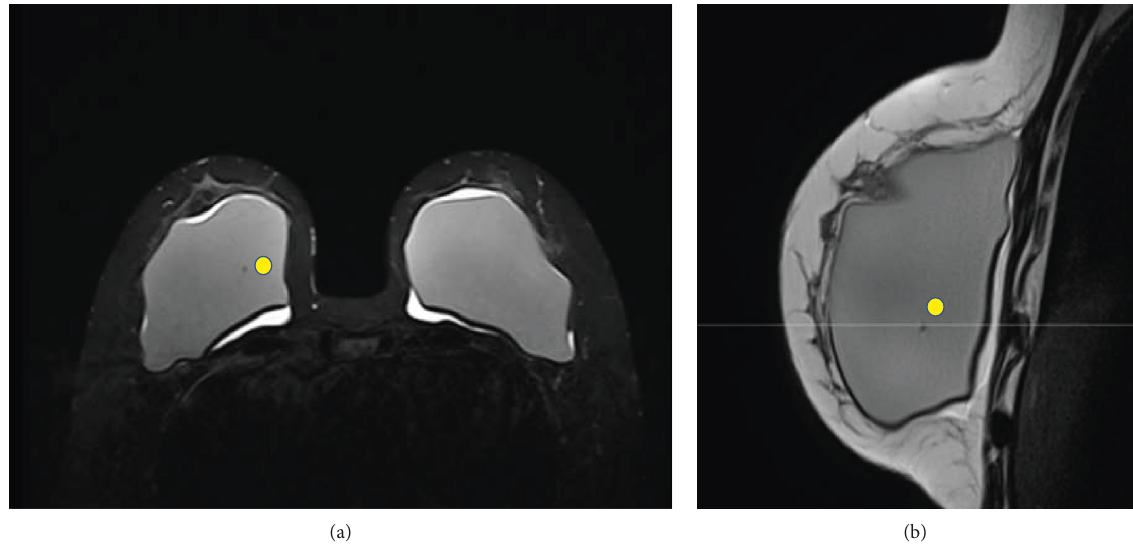
Figure 5: (a and b). Sign of permeability change of the implant surface (“water-droplet”) market with the yellow circle. This sign cor- responds to the change of the selective permeability property of the implant shells. Axial STIR sequence (a) and sagittal proton-density sequence (b). Intracapsular collection is also observed.